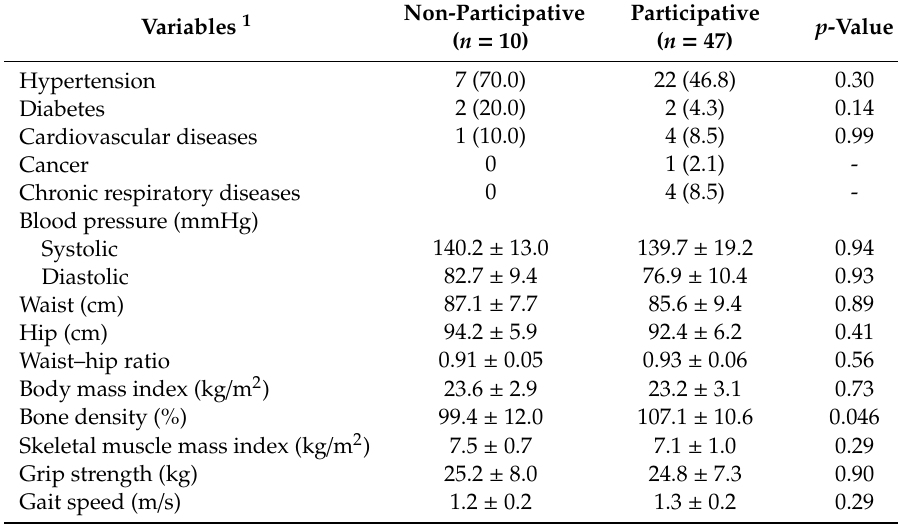
Table 5. Physical status related to NCDs of socially participative and non-participative groups in Japanese older adults.